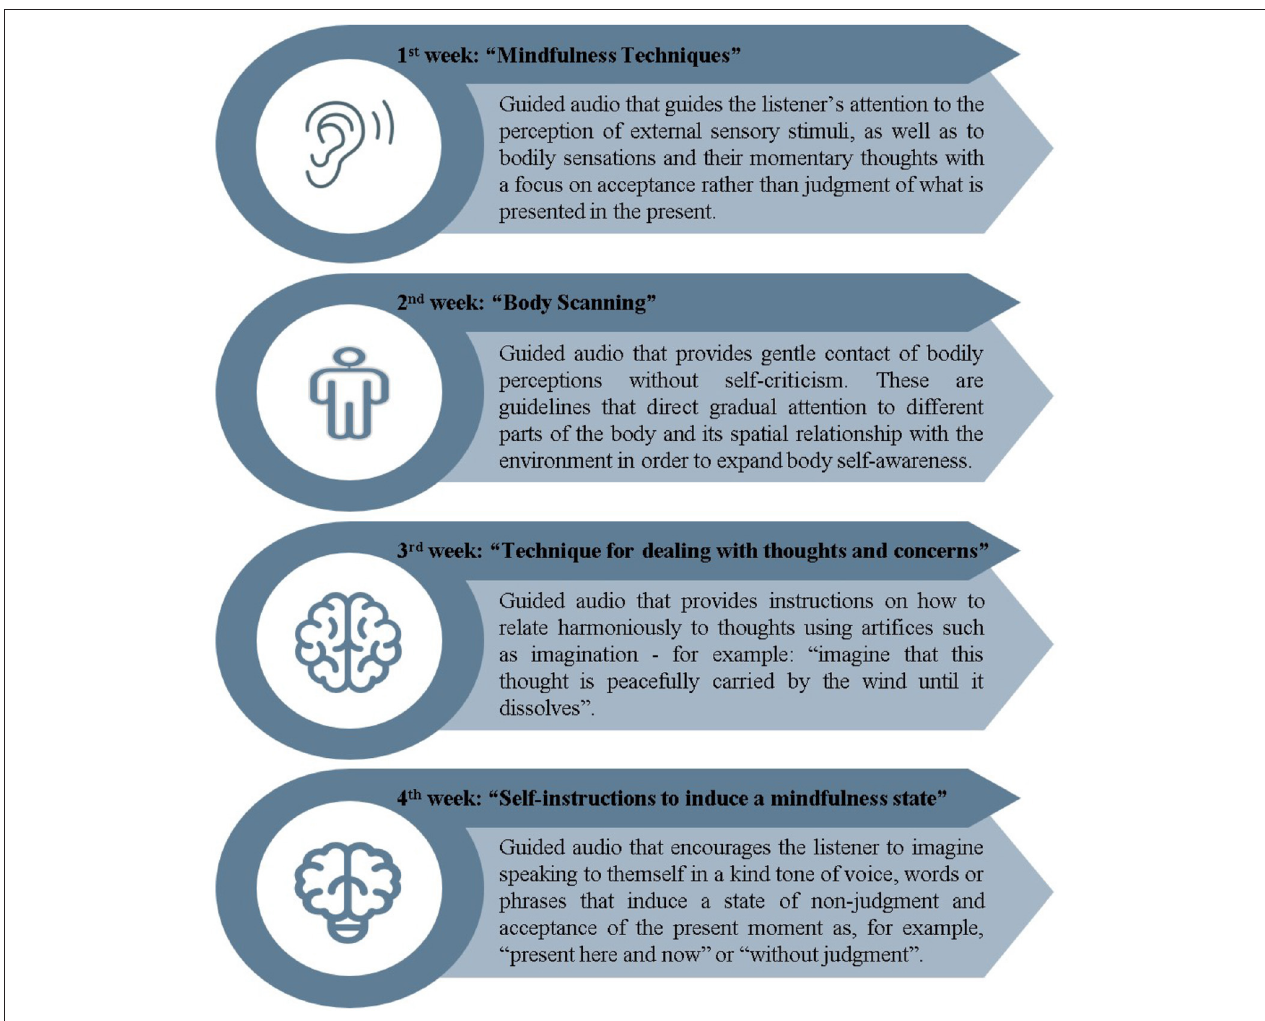
FIGURE 2 | Mindfulness protocol used in the 4 weeks of